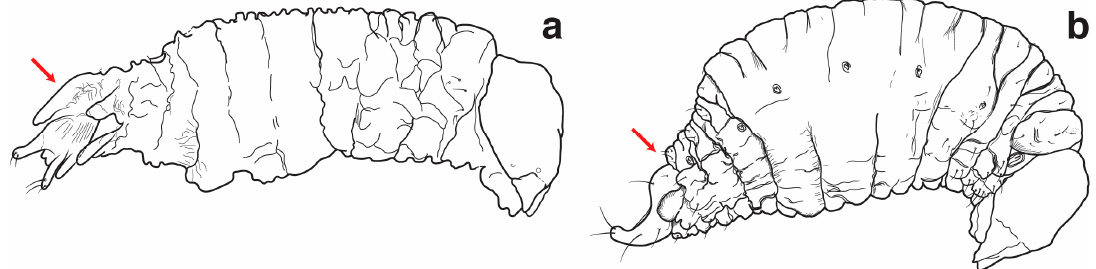
Figure 12. Larvae, lateral view: ( a ) Nephius (= Anius ); ( b ) Phacecorynes .